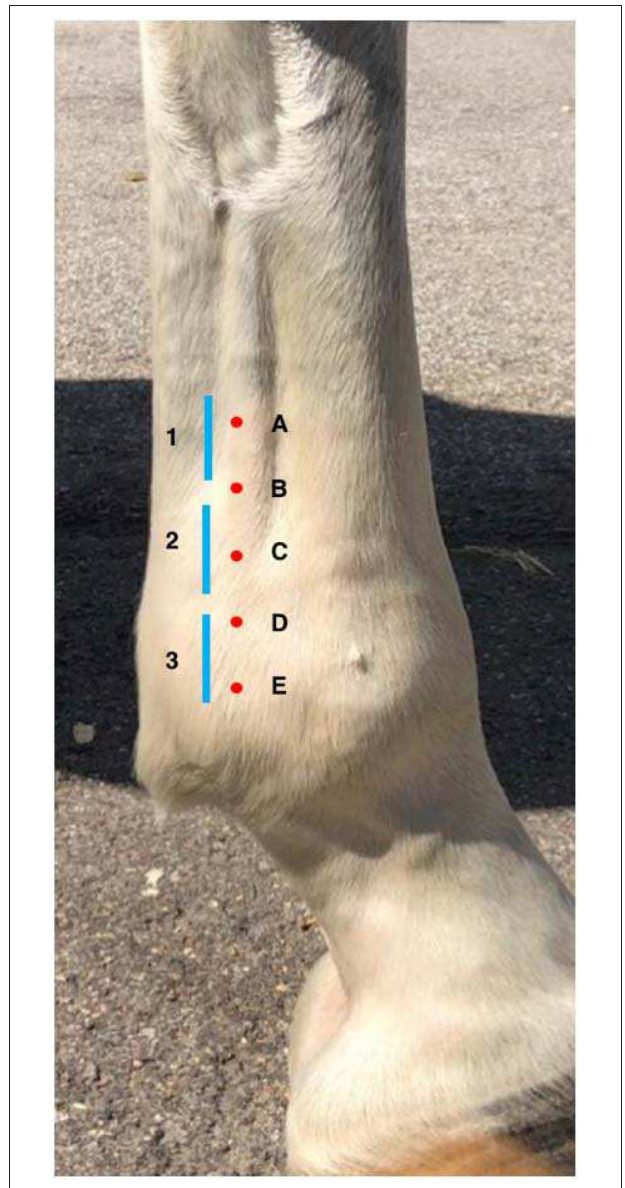
FIGURE 1 | This is a schematic illustration of the location that each of the eight ultrasonogram sections were acquired and stored, where the red dots represent the approximate location of the five transverse sections (A–E) proximal to distal and the blue lines represent the approximate location of the and three longitudinal sections, numbered 1–3 proximal to distal. These were acquired based on the approximate distance from the proximal sesamoid bones, however, the entirety of the branch was examined and therefore exact site of the stored images were also adjusted based on ultrasonographic branch shape and